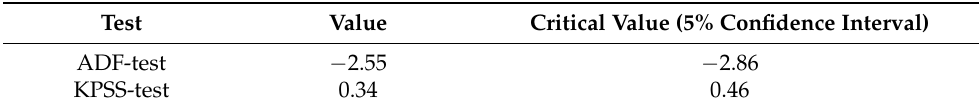
Table 2. Results of the ADF and KPSS tests for the Poland electrical load dataset.